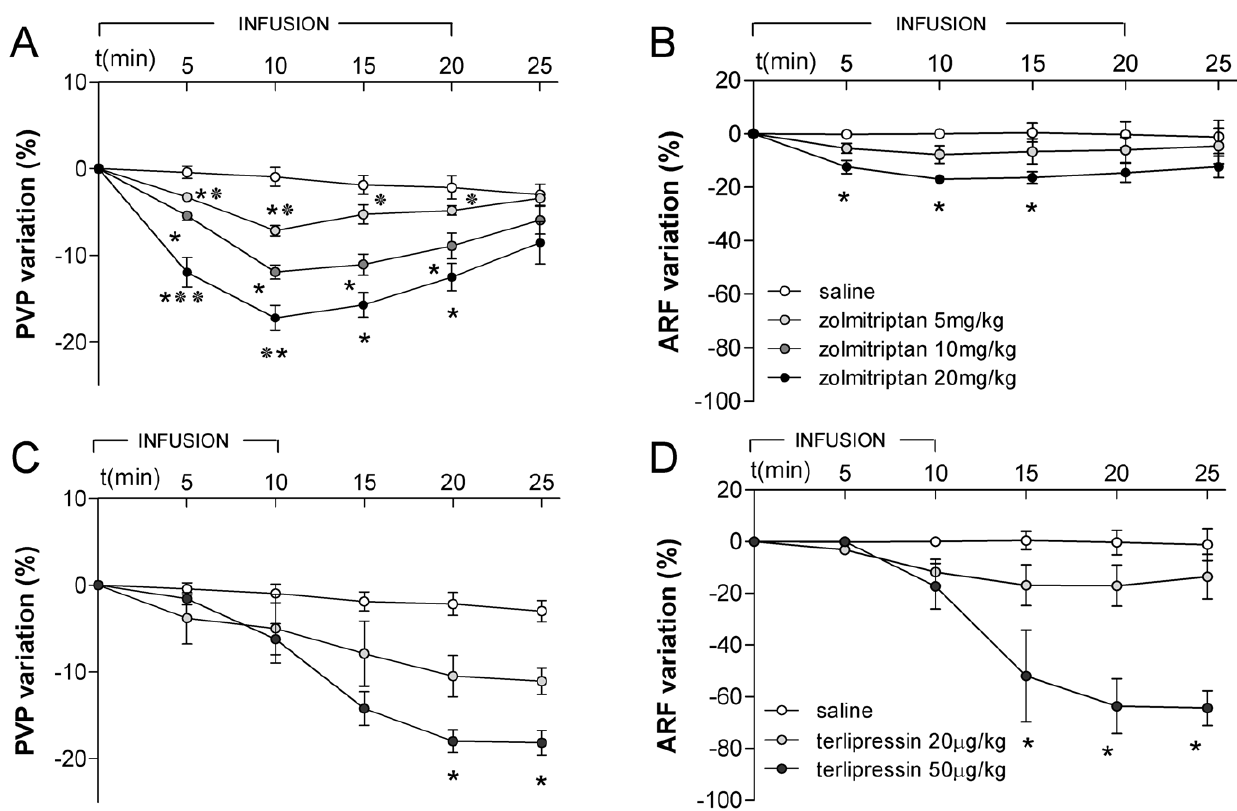
Figure 1. Effect of intravenous infusion of zolmitriptan and terlipressin in CBDL-rats. (A,C) Portal pressure (PVP). (B,D) Renal flow (ARF). *p , 0.05 vs saline. */**p , 0.05/0.01 vs zolmitriptan dose 10 mg/kg.